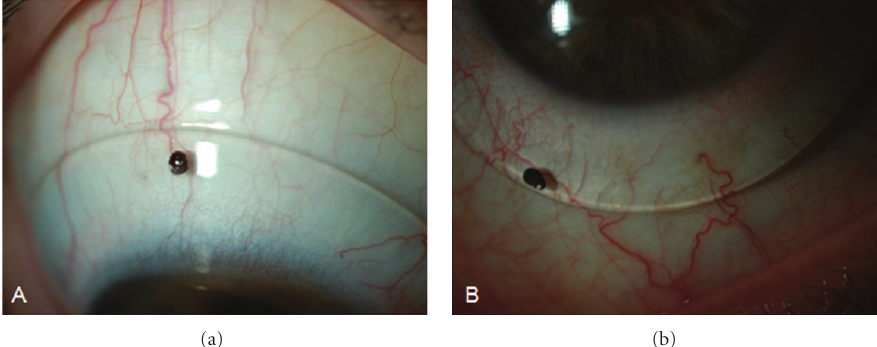
Figure 5: Slit lamp photos showing device orientation used to define sampling axis of device profile to test for correlation with scleral toricity derived from OCT image. (a) Eye #3: 0 degrees of rotation. (b) Eye #6: 30 degrees of rotation.